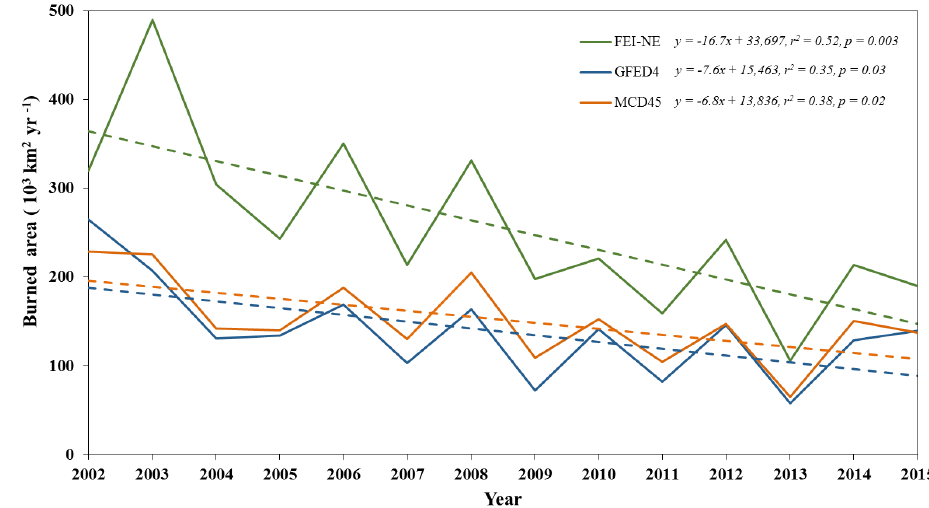
Figure 2. Comparisons of burned areas over northern Eurasia from 2002 to 2015 mapped by FEI-NE, GFED4, and